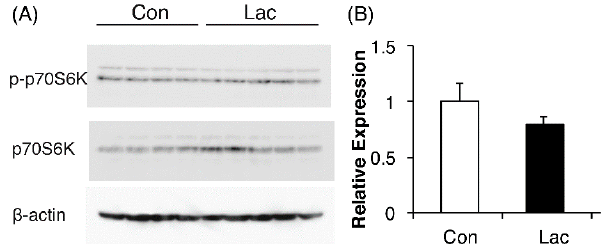
Figure 3. Lactate did not affect the protein synthesis pathway in C2C12 myotubes. ( A ) C2C12 cells were differentiated in control medium (Con) or medium containing 10 mM sodium lactate (Lac) for 5 d. Cells were harvested on day 5 and protein levels of P70S6K, p-P70S6K, and β -actin were analyzed by immunoblotting. ( B ) P70S6K phosphorylation levels (p-P70S6K/P70S6K) are expressed as fold change compared with that in the Con group ( n = 4–5 per group). Results are expressed as mean ±